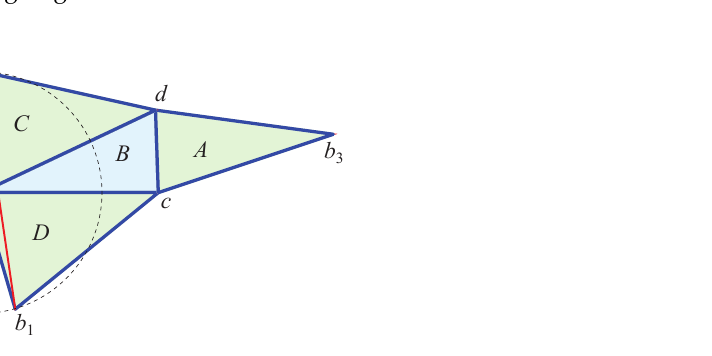
Figure 4. Case 2.1: b is closest to a . Curvatures at a , b , c , d are 196 ◦ ,190 ◦ ,159 ◦ ,175 ◦